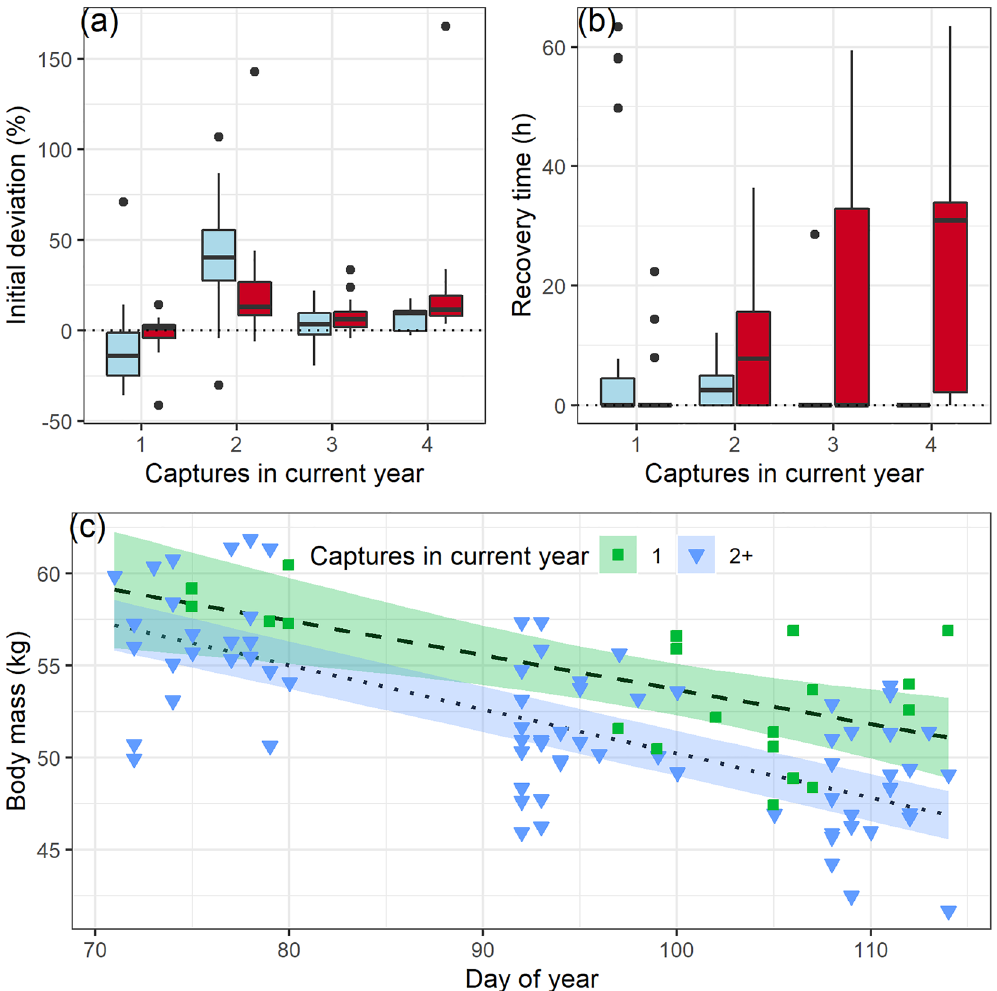
Figure 5. Short-term effects of repeated captures on activity and heart rate in Svalbard reindeer during winter 2018. ( a ) Initial deviation from baseline values of activity (blue) and heart rate (red) given in percentages and ( b ) time taken to return to baseline values, for activity and heart rates after each capture event. In both panels, boxes show median (solid line), the 25th and 75th percentiles (lower and upper hinges), with whiskers corresponding to max. 1.5 times the inter-quartile range. Outliers are shown as solid circles. ( c ) Winter body mass as a function of time (days since January 1st), in individuals who were captured more than once (blue, triangles) and for individuals captured only once (green, squares). Lines and shaded area show the predicted slopes with 95% confidence intervals, and points are adjusted for age and pregnancy